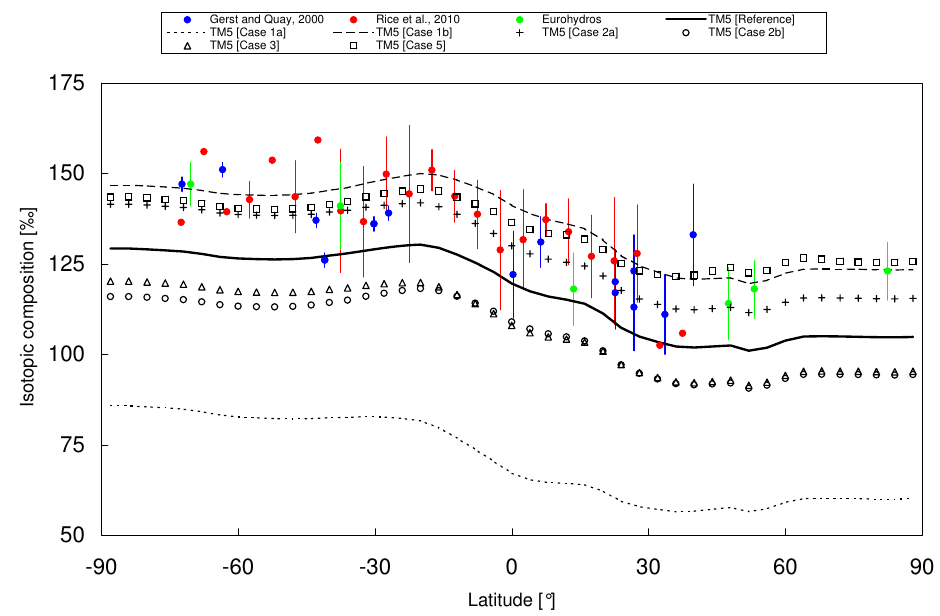
Fig. 3. Comparison of the modelled zonal mean surface isotopic composition (thick solid line) with available measurements. Blue circles represent measurements from Gerst and Quay (2000), red circles represent measurements from Rice et al. (2010), and green circles represent measurements from the Eurohydros project (Batenburg et al., 2011). Also shown are some of the cases of the sensitivity study discussed in Sect. 3.6. Case 1a shows the effect of using the KIEs for formaldehyde photolysis as proposed by Feilberg et al. (2007a), case 1b shows the effect of changing the pressure dependency of the molecular photolysis channel for formaldehyde, case 2a shows the effect of increasing the stratospheric isotopic composition by 20‰, case 2b shows the effect of shifting the tropopause pressure level, case 3 shows the effect of decreasing the isotopic composition of the primary NMHCs to − 200‰, and case 5 shows the effect of reducing the deposition fractionation constant to